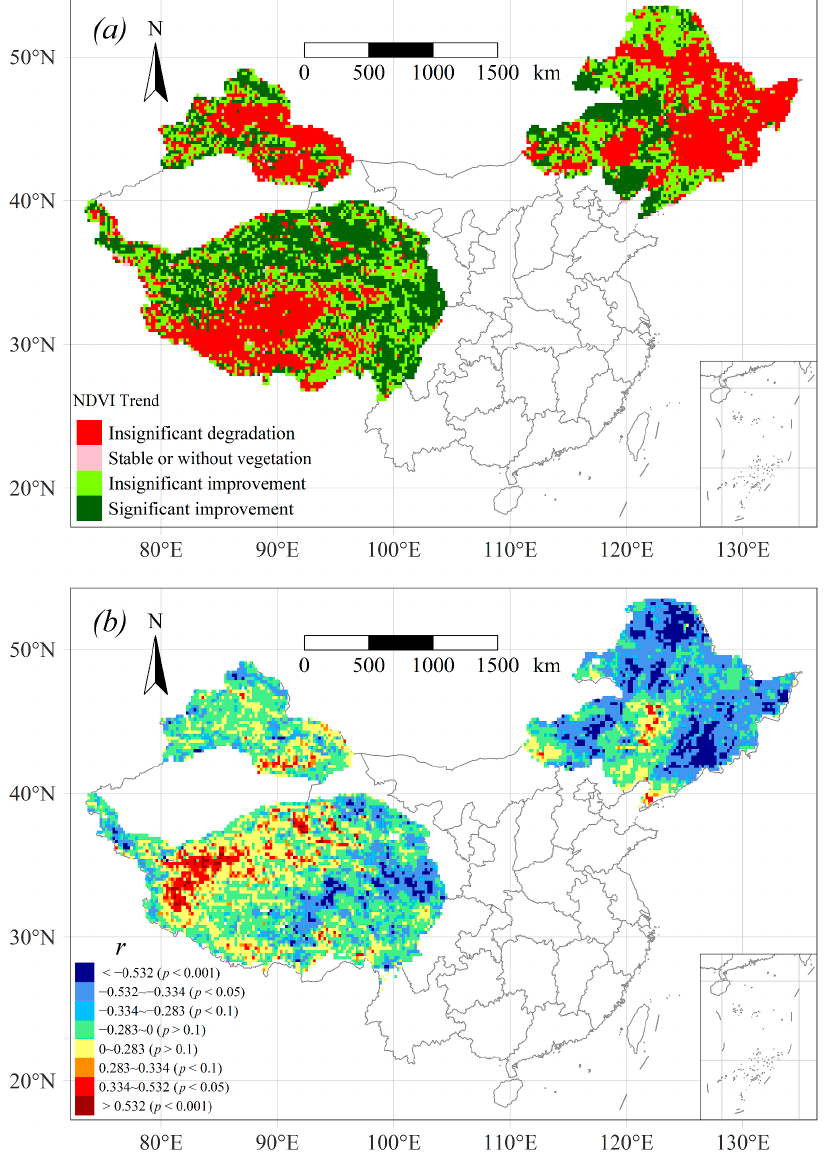
Figure 8. Spatial trends of the ( a ) NDVI in spring (significant level is p < 0.05) and ( b ) correlation coefficient between the interannual NDVI in spring and the snowmelt rate in spring from 1982 to 2015, across stable snow cover regions of China.